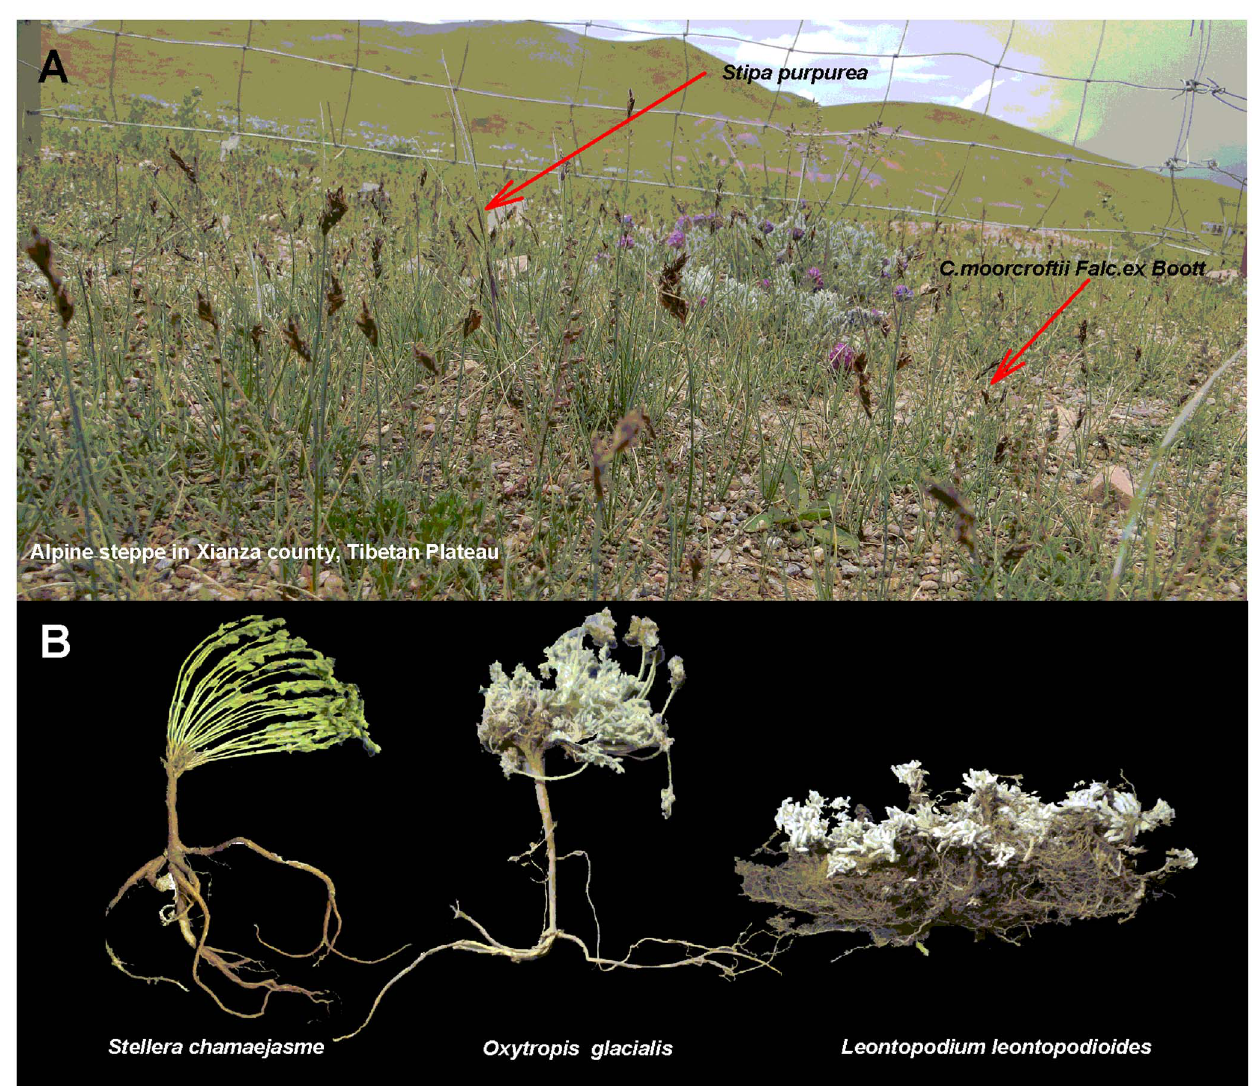
Figure 2. The vegetation composition diagram is in the study area. The Vegetation coverage of the alpine steppe was about 20%, which are dominated by Stipa purpurea and Carex moorcrofii (panel A) and the accompanying species are Stellera chamaejasme Linn. , Leontopodium alpinum , Oxytropis microphylla (panel B) and so on.